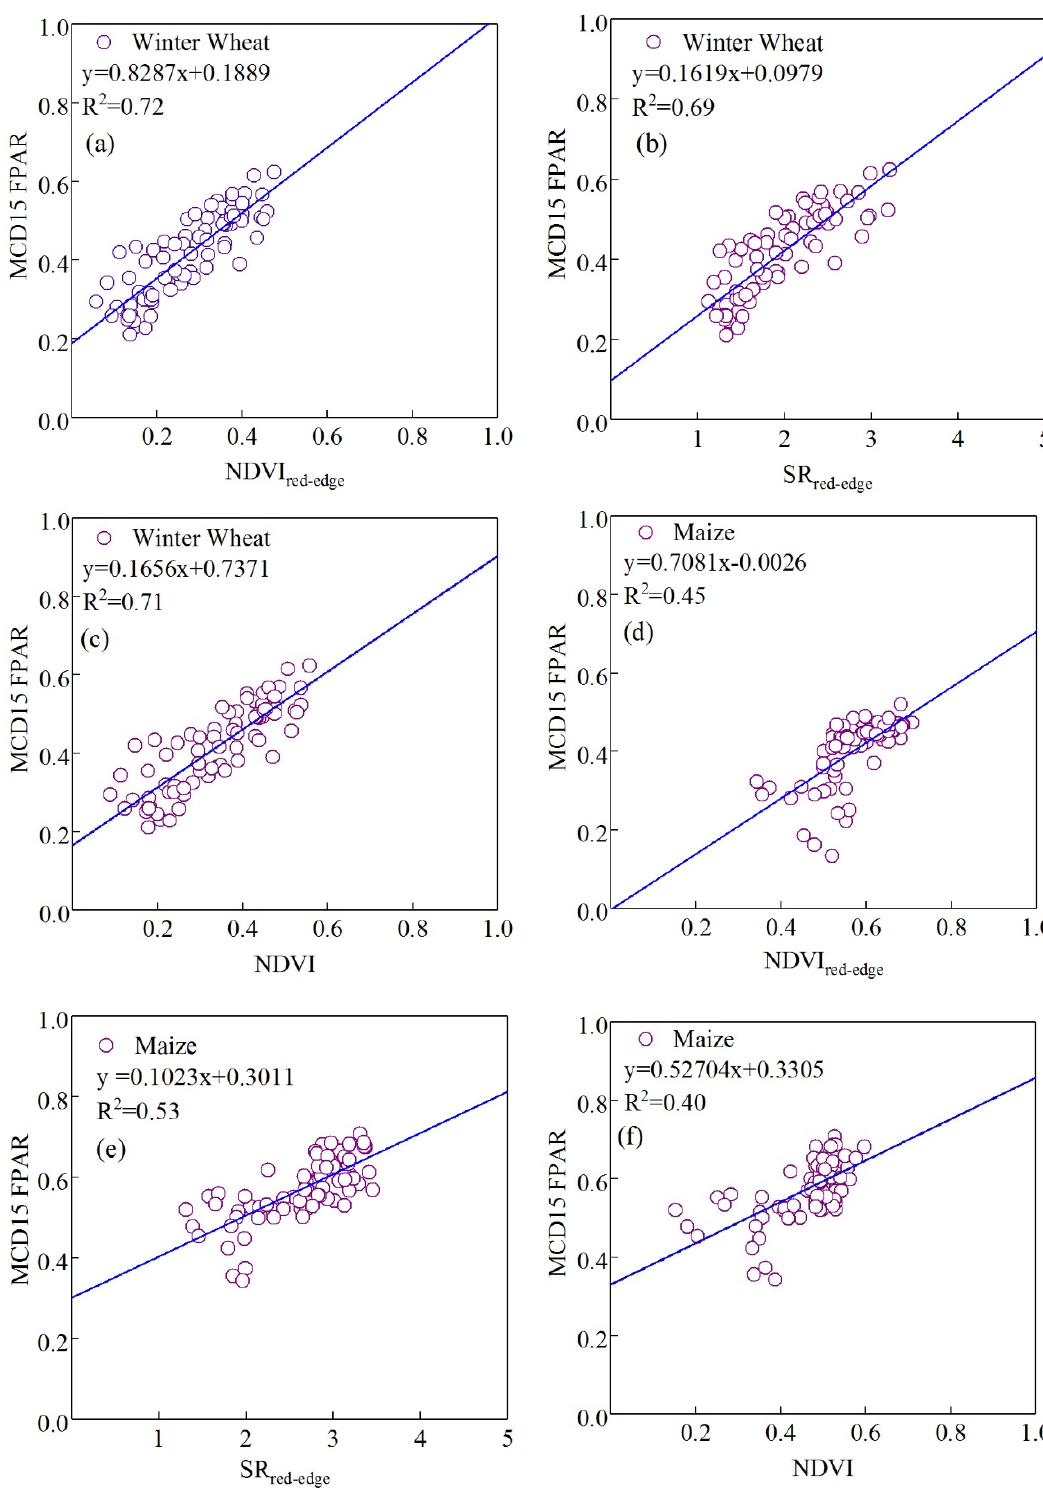
Figure 6. Correlation between the vegetation indices and the reference FPAR. ( a – c ) Correlation between the NDVI red − edge , SR red − edge , NDVI, and MODIS FPAR during the winter wheat growing season. ( d – f ) Correlation between the NDVI red − edge , SR red − edge , NDVI, and MODIS FPAR during the maize growing season.